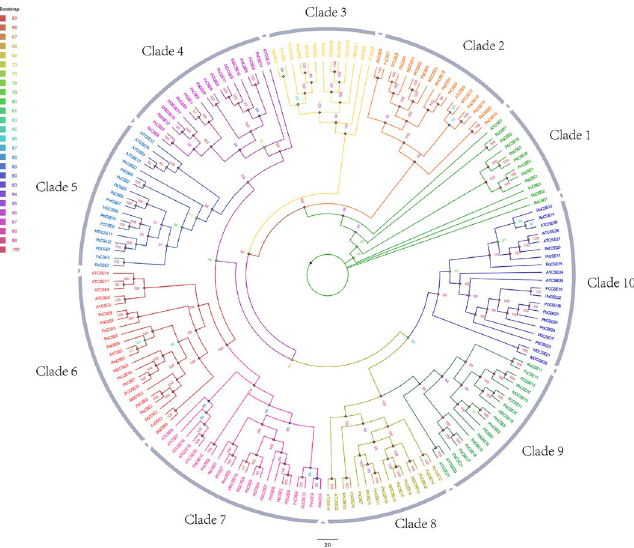
Figure 1. Phylogenetic analysis of CSE proteins from different plant species. The ten plant species included Arabidopsis thaliana , Pyrus communis , Pyrus bretschneideri , Fragaria vesca , Malus , Mume , Cerasus , Amygdalus , PopulusL and Rubus . The protein sequences were aligned and a phylogenetic tree was constructed using the maximum likelihood (ML) method and IQ-TREE1.6.9 software. The number (42–100) indicated the confidence level, which varies by its color. The information about the CSE genes in ten species from the family evolution tree was listed in Supplementary Table S3